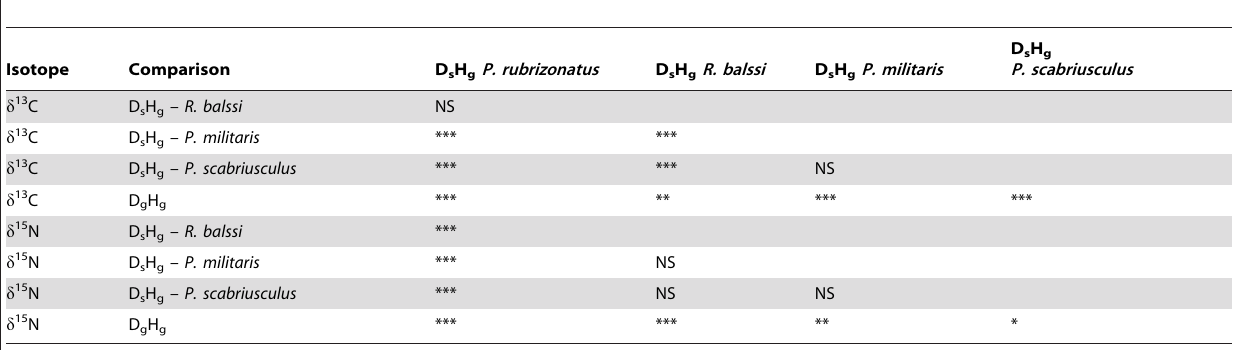
Table 5. Tukey’s post hoc results comparing variances between models using the common prey species and incorporating distance between sites (Part 2).